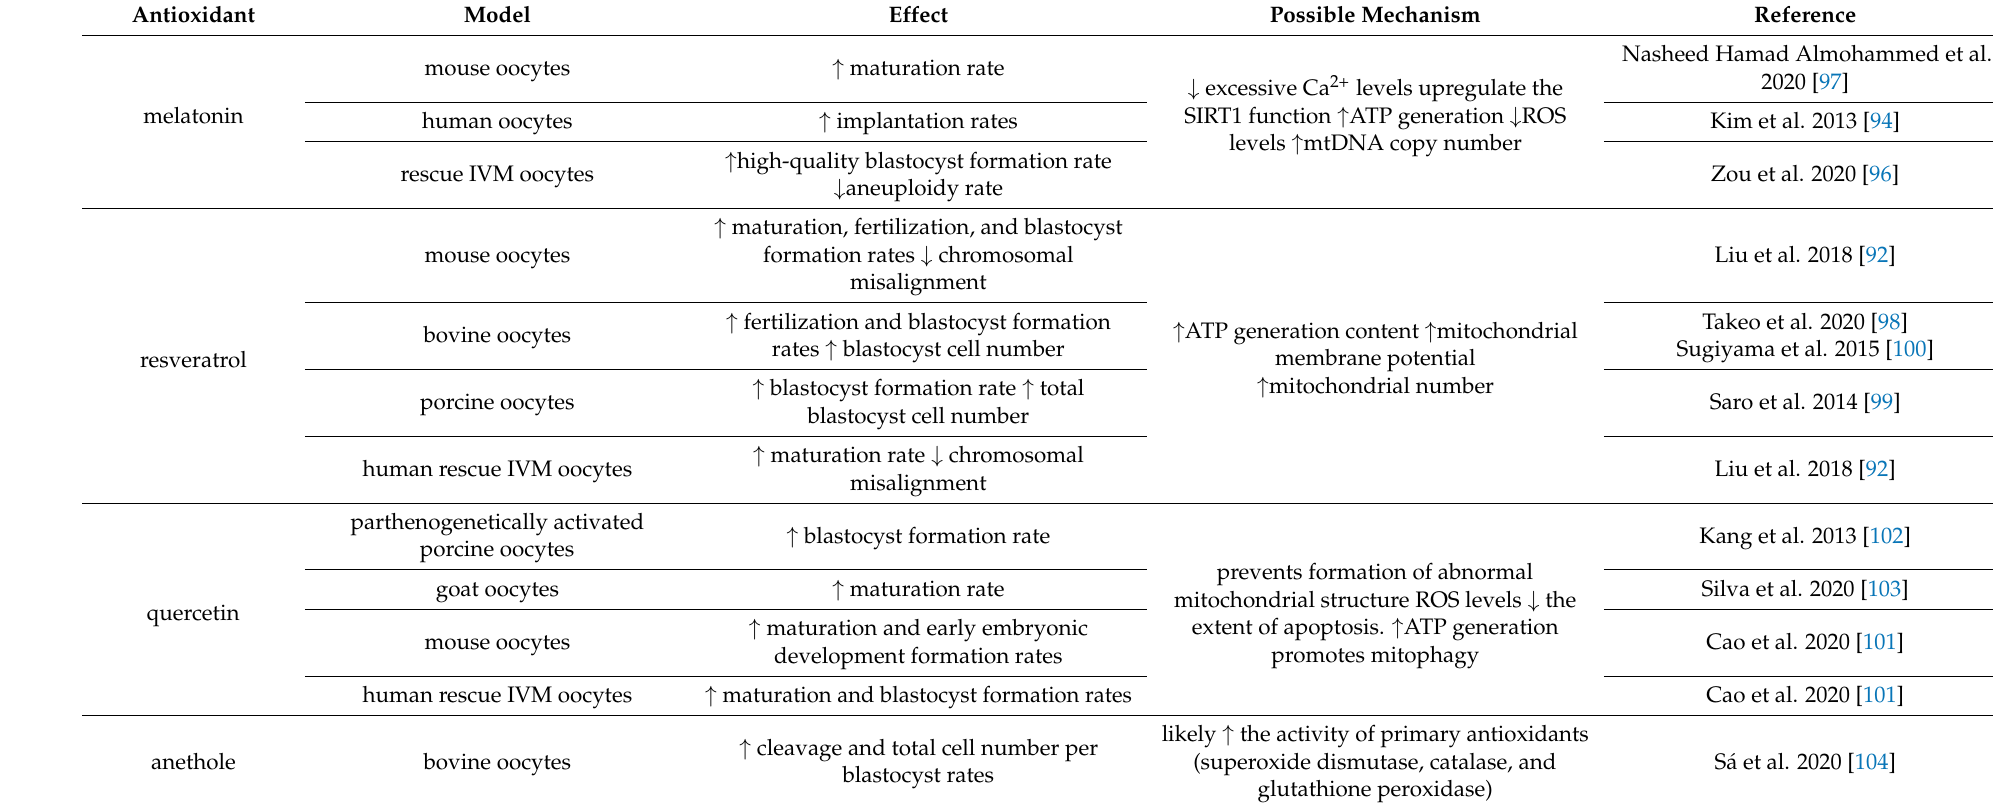
Table 1. Summary of the antioxidants applied for IVM culture improvement. IVM: in vitro maturation. ↑ : increases. ↓ : decreases. ROS: reactive oxygen species. CoQ10: coenzyme Q10. AMPK: AMP-activated protein kinase. mtDNA: mitochondrial DNA. MitoQ: Mitoquinone mesylate. SIRT1: